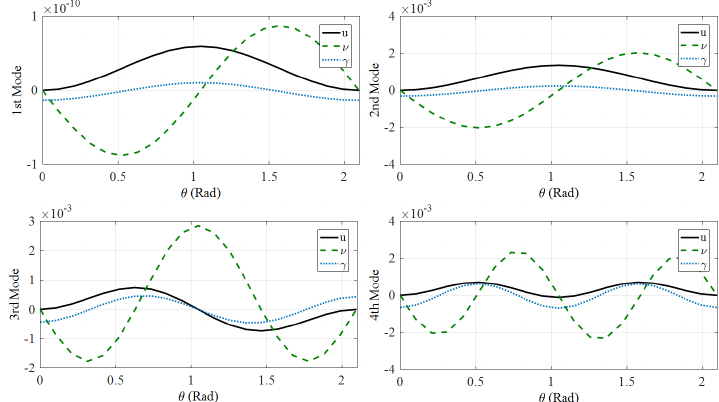
Figure 10. Displacement of nodal points of the curved beam without absorber for the first four modes (S-S)